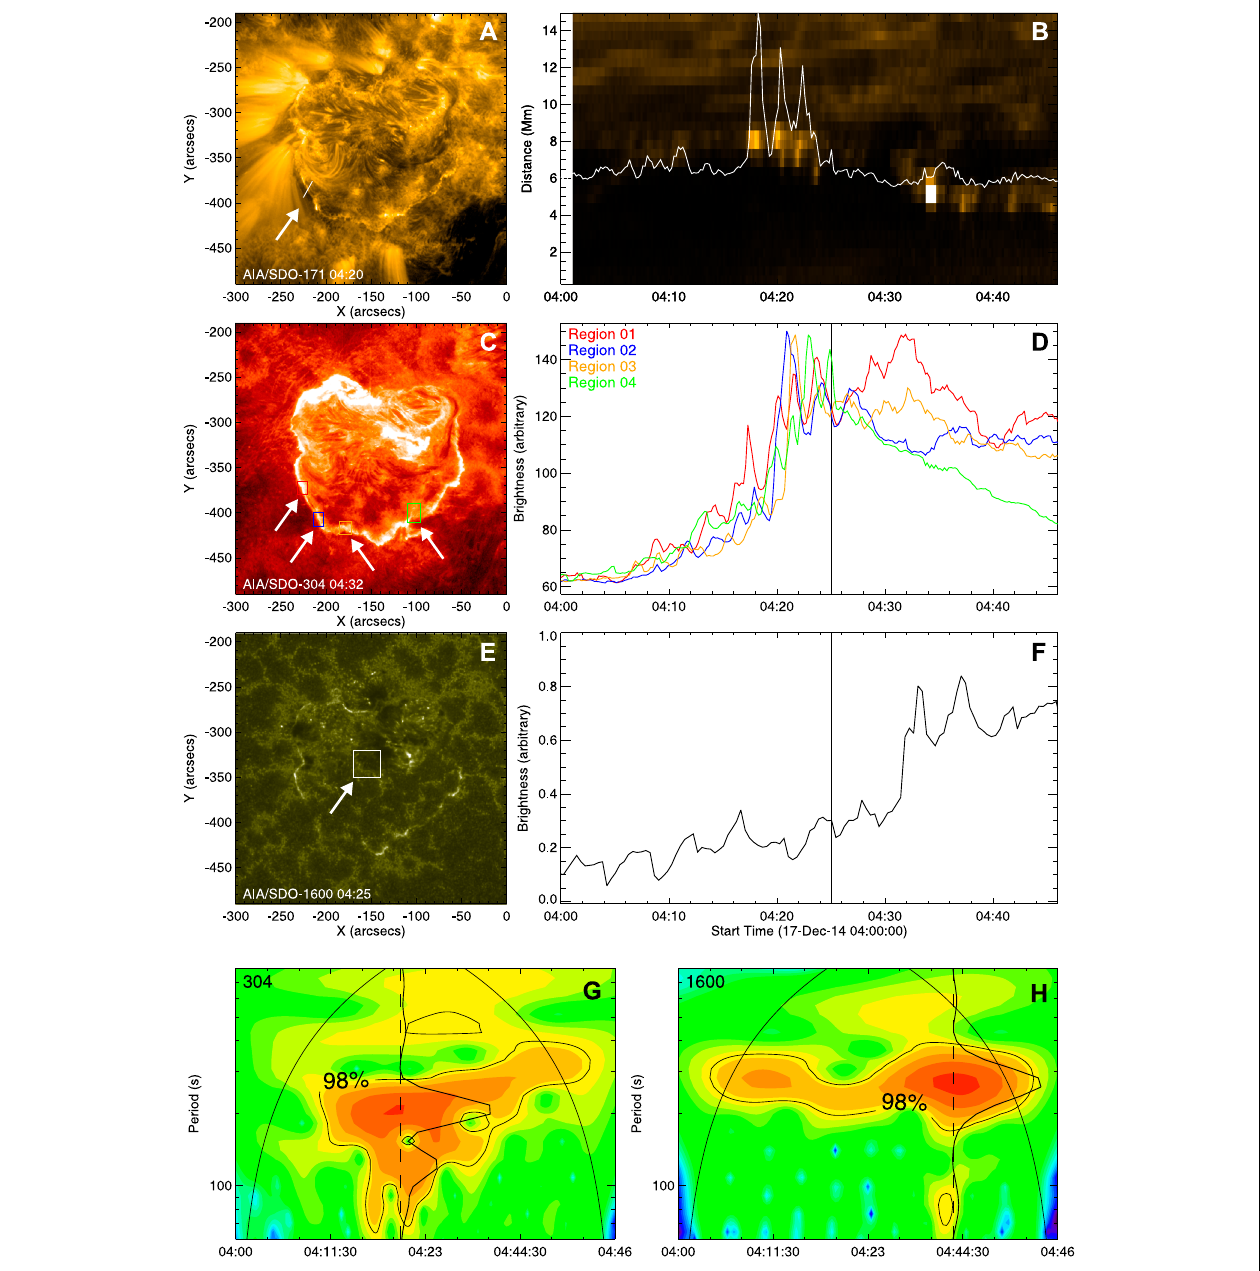
FIGURE 7 | AIA (E)UV observations and wavelet analyses. Upper left panels show AIA (E)UV images: 171 Å (A) , 304 Å (C) , and 1,600 Å (E) . Upper right panels show time profiles of the mean intensity calculated from the box(es) marked in the left panels: the time–distance map and the time profile of the 171 Å intensity in the center of the slit (B) , the average 304 Å intensities in the four local regions (D) , and that of the 1,600 Å intensity (F) . The vertical line represents the starting time of this flare based on the GOES lightcurves. Bottom two panels show the wavelet analysis results of the 304 Å flux collected from the red box (G) and that of the 1,600 Å from the white box (H) . (Source: Chen et al., 2019).